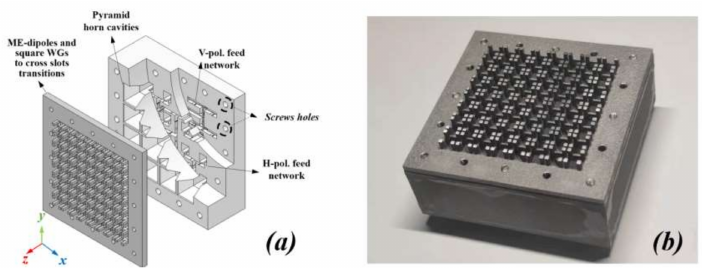
Figure 10. Photograph of the fabricated 8 × 8-unit ME-dipole antenna array: ( a ) perspective view; ( b ) prototype of the dual polarization